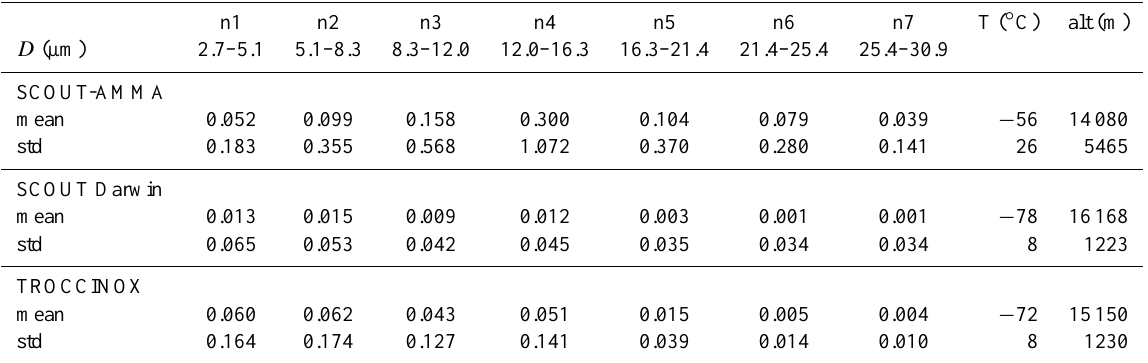
Table 1. Averages and standard deviations of the particle density in cm − 3 within each diameter bin of the size distribution histogram are reported, as measured by the FSSP-100, for clouds observed in each of the three M55 Geophysica deployments (TROCCINOX, Bauru, 2004; SCOUT-Darwin; Darwin, 2005; SCOUT-AMMA; Ouagadougou, 2006). The diameter range of each bin is reported in the second row of the table, where minimum and maximum particle diameter for each bin are reported. In the two columns on the right, the mean value and standard deviation of cloud altitudes and temperatures are